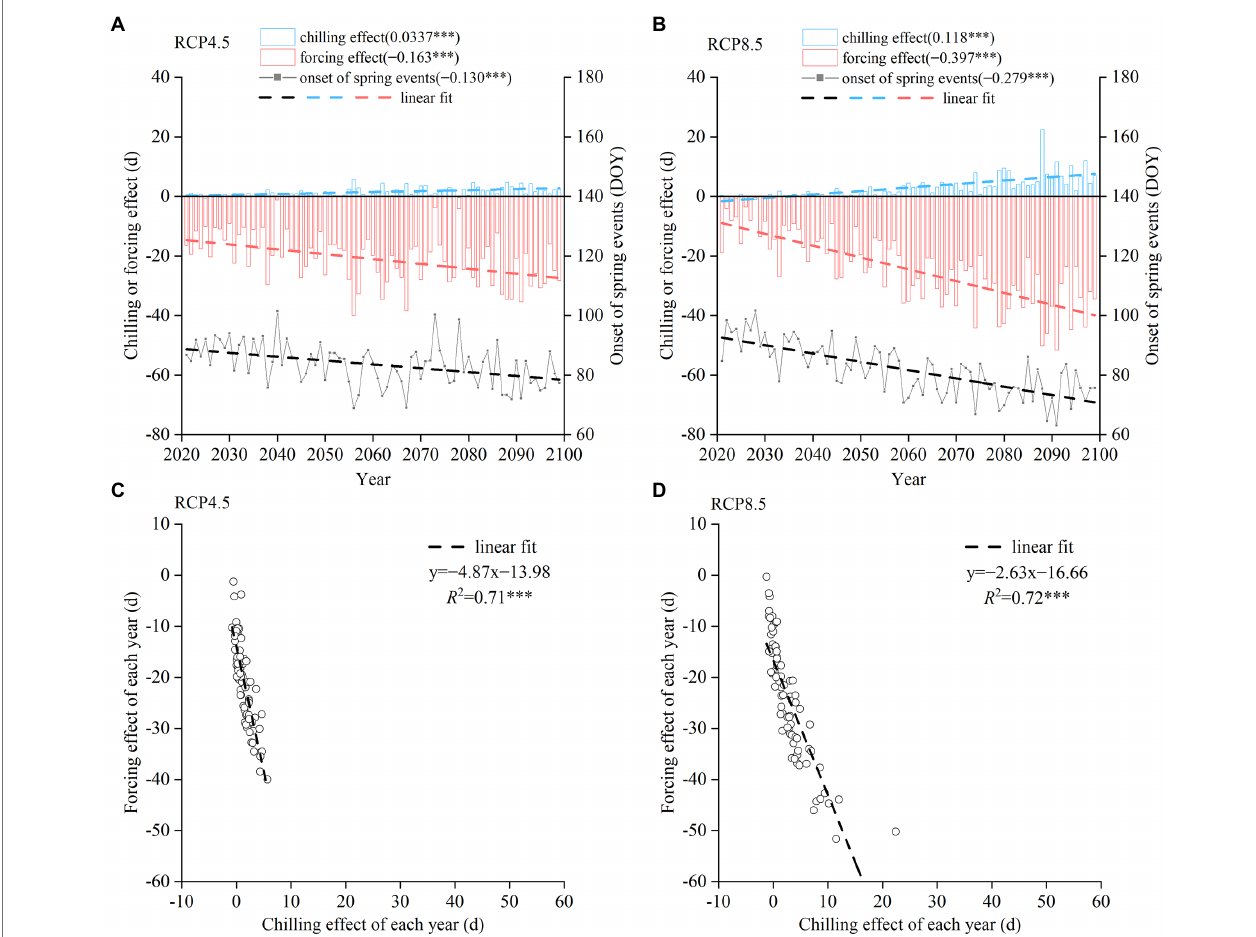
FIGURE 6 | Simulated change in the spring phenophases of 14 woody species during 2021–2099. (A,B) Annual chilling effect, forcing effect, and the onset date of spring events averaged from 14 species under RCP 4.5 (A) and RCP 8.5 (B) . DOY: day of the year. (C,D) Relationship between chilling effect and forcing effect across years under RCP 4.5 (C) and RCP 8.5 (D) . *** p <